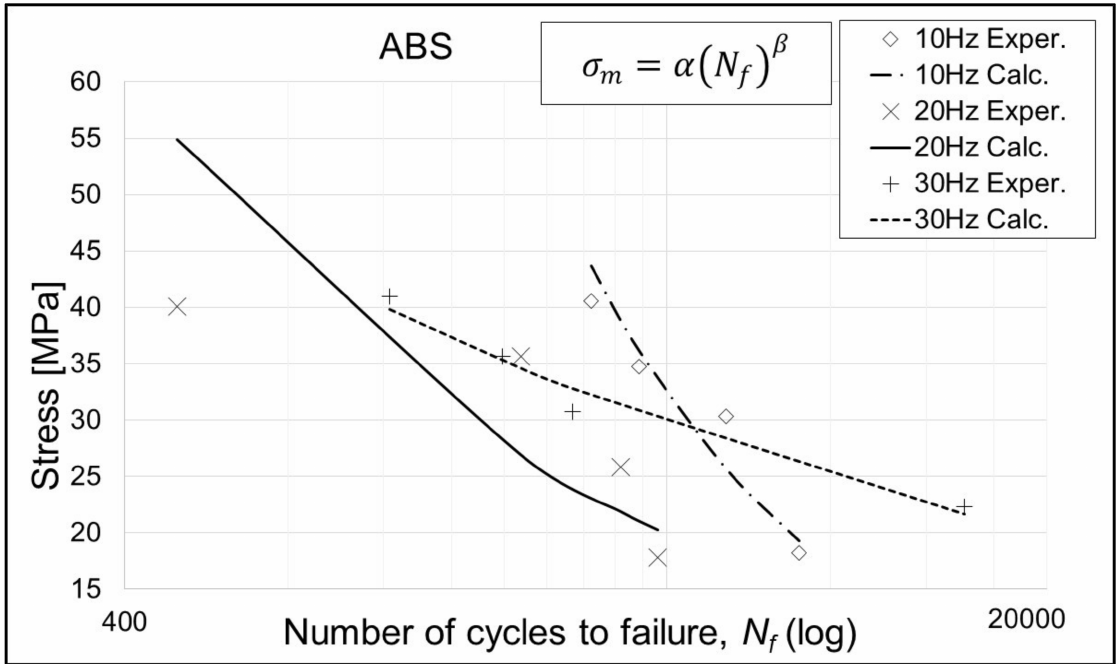
Figure 5. S–N curves for ABS specimens. Exper.—Experimental;